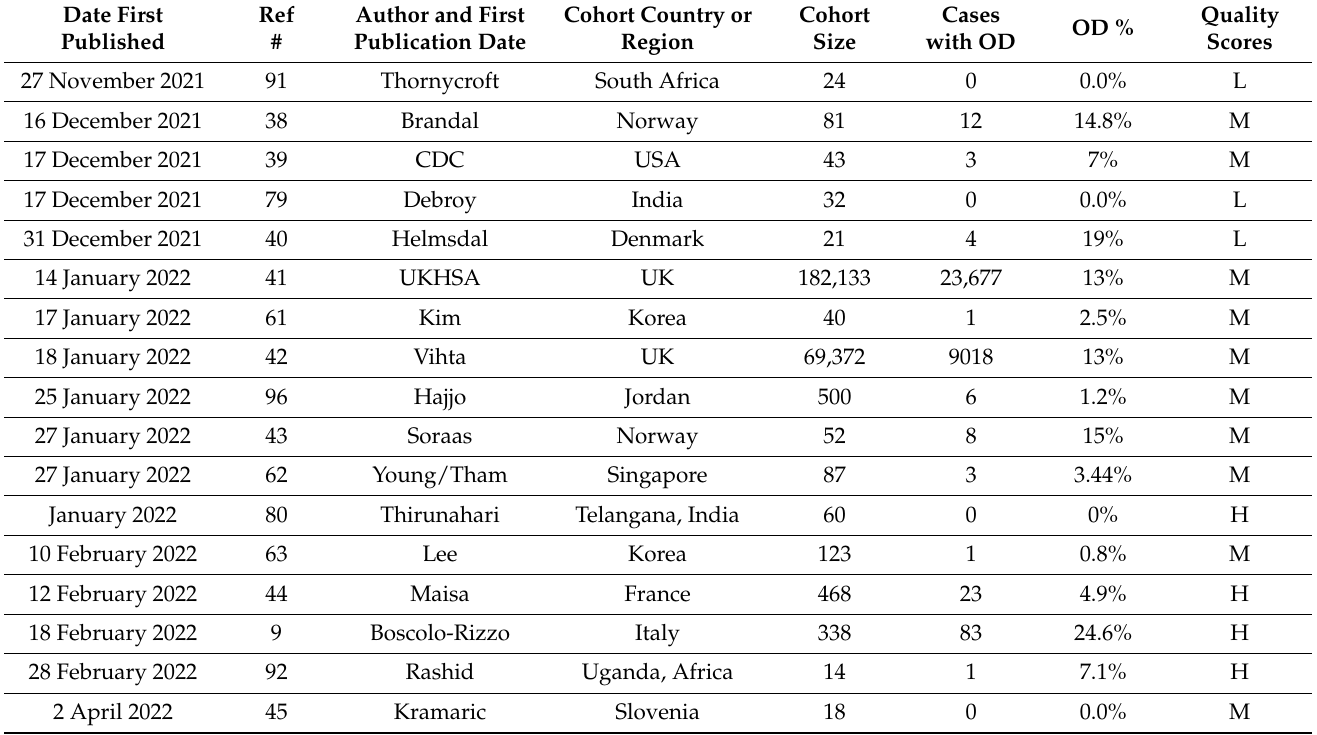
Table 1. List of studies reporting the prevalence of olfactory dysfunction (OD) caused by the omicron